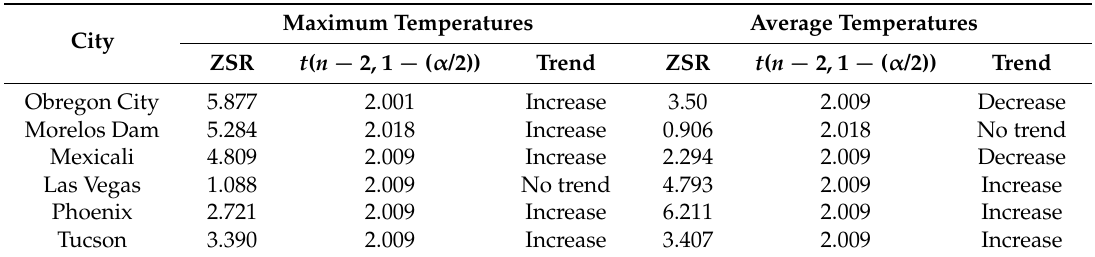
Table 1. Results of Spearman’s rho test for August at a significance level of α = 0.05.